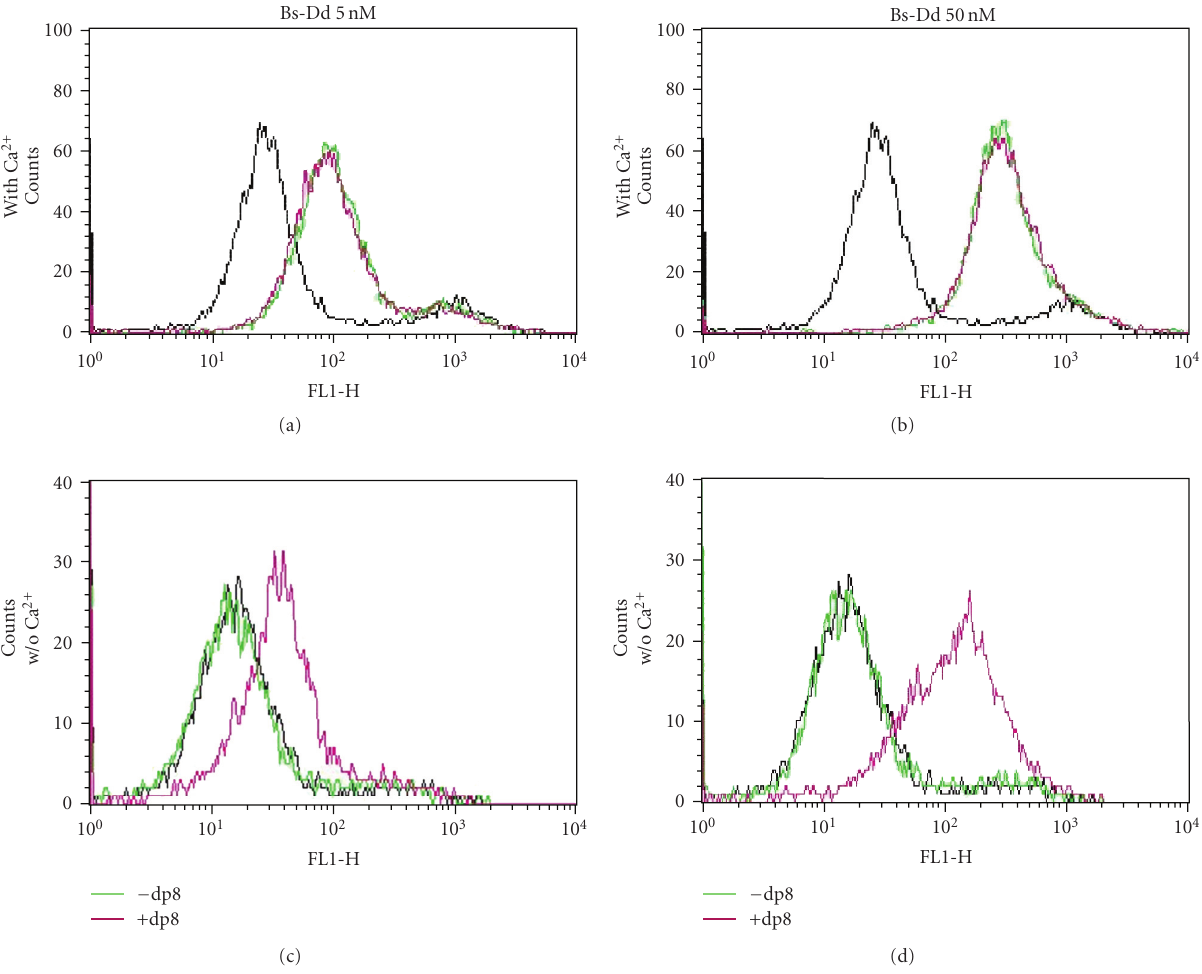
Figure 4: FACS analysis of the dp8 e ff ect on Bs-Dd binding to HSPG deficient CHO-2241 cells in presence or absence of calcium. Bs-Dd was incubated at two di ff erent concentrations with CHO-2241 cells at 4 ◦ C in PBS supplemented or not with 1 mM CaCl 2 (upper and lower panels, respectively). Bound Bs-Dd alone (green curves), or preincubated with dp8 oligosaccharide (purple curves), was detected by an antibody serum directed against the HAd3 penton